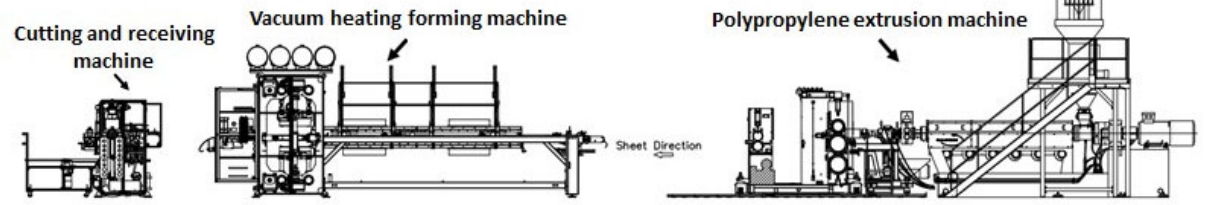
Figure 4. The schematic of polypropylene extrusion and thermoforming in-line system (Reprinted with permission from Ref. [33]. Copyright 2022, Sunwell Global).